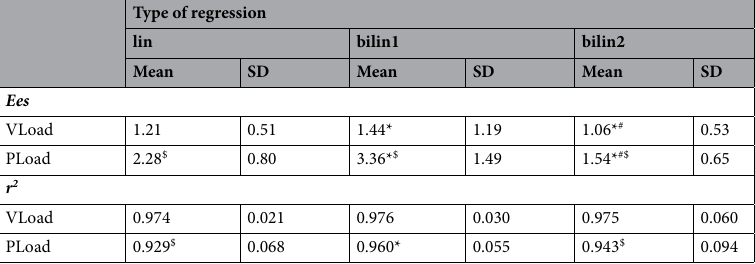
Table 1. Effect of preload (VLoad) and afterload (PLoad) interventions on the slope (Ees) and goodness of fit (r 2 ) of the ESPVR derived from single linear regression (lin) and two phases of bilinear (bilin1, bilin2)) regression. The means and standard deviations (SD) are shown (*p < 0.05 vs. lin; # p < 0.05 vs. bilin1, $ p < 0.05 vs. VLoad).